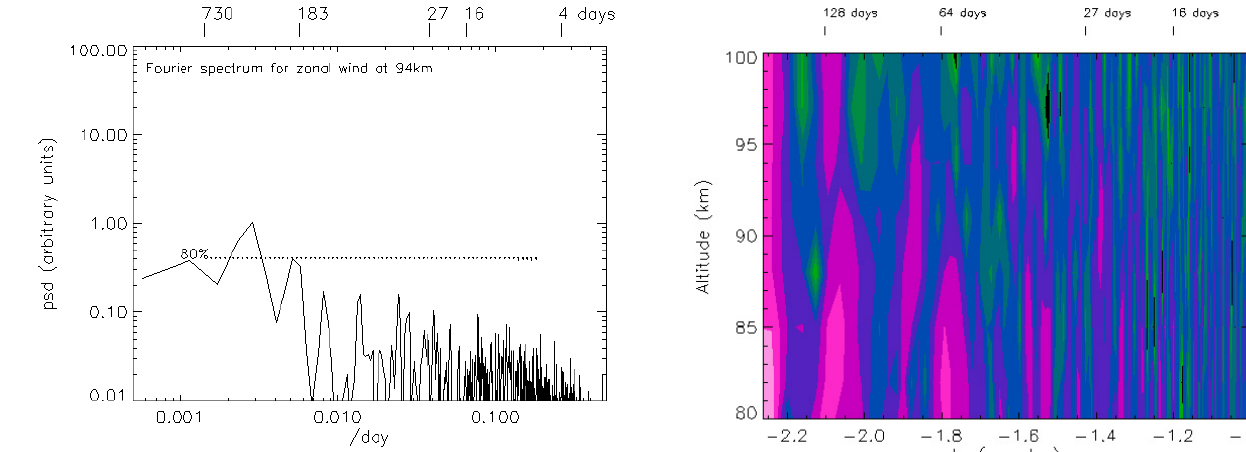
Fig. 10. As for Fig. 4 but for the zonal wind. Contours show power spectral density in arbitrary units, the absolute values of which may be obtained from Fig.